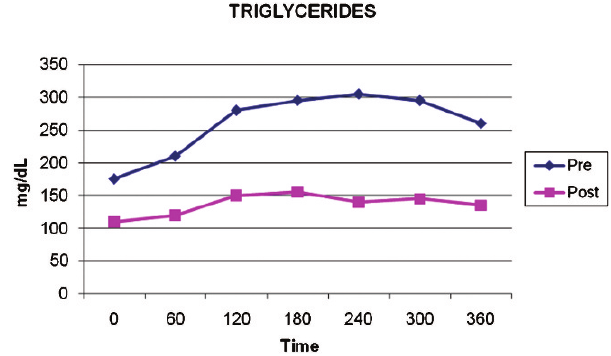
Figure 1 - Mean levels of GLP-1 at fasting and 30, 60, 90, and 120 minutes after a standard meal, pre- and postoperatively. * p , 0.005.